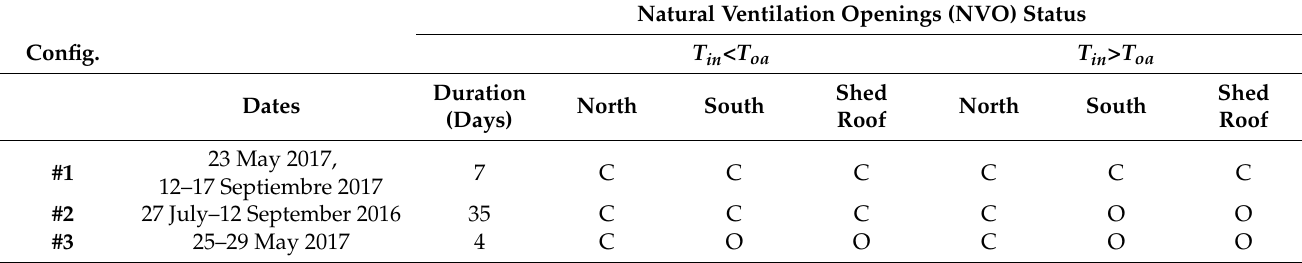
Table 3. Configurations of the openings on each measurement campaign.